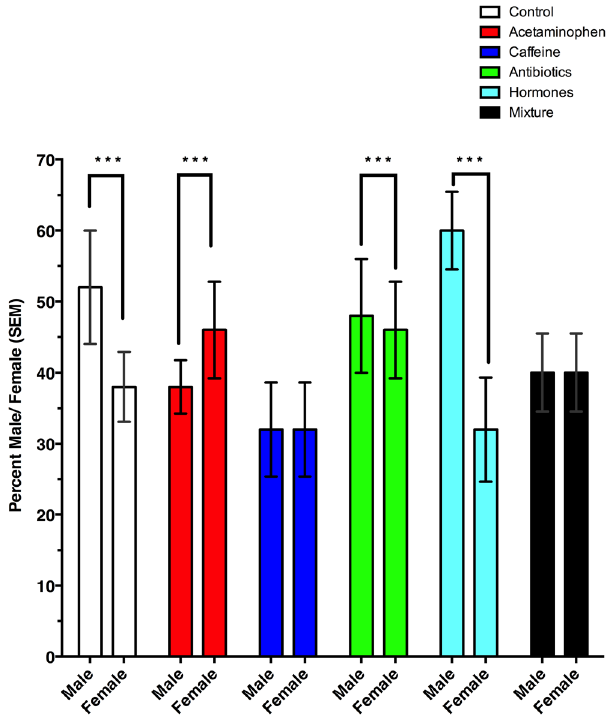
Figure 3. Male: female ratios of Megaselia scalaris fed diets contaminated with common pharmaceuticals found in reclaimed water. *** Denotes a significant difference in sex ratio with respect to